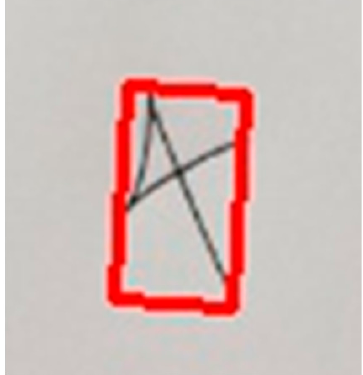
Figure 7. Circumscribed rectangle of the digit “4”.